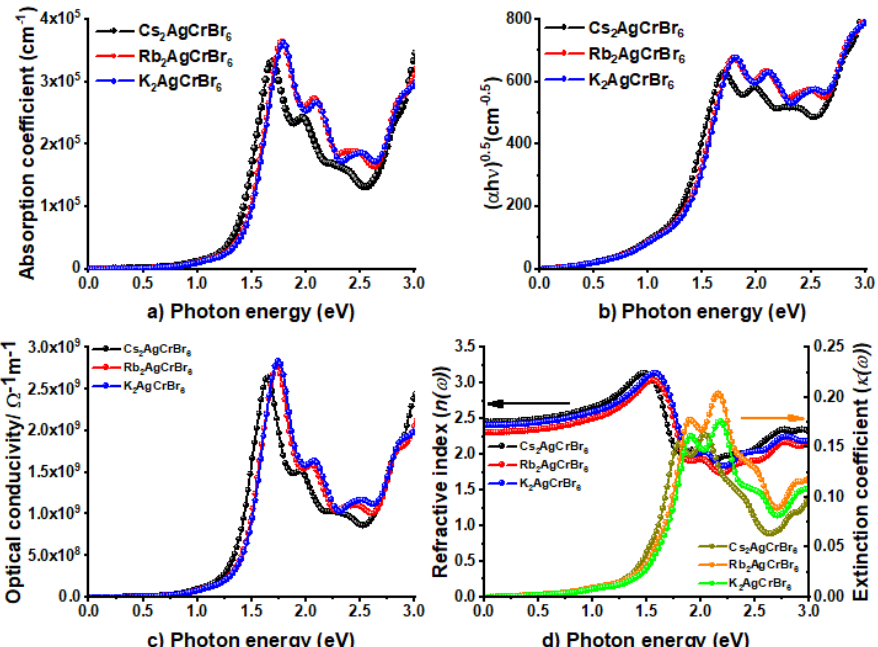
Figure 7. Illustration of the dependence of ( a ) absorption coe ffi cient ( α ( ω ) ), ( b ) Tauc plot, ( c ) optical conductivity ( σ ( ω ) ), and ( d ) the real and imaginary parts of refractive index ( n and κ , respectively) on the photon energy for A 2 AgCrBr 6 ( A = Cs, Rb, K).